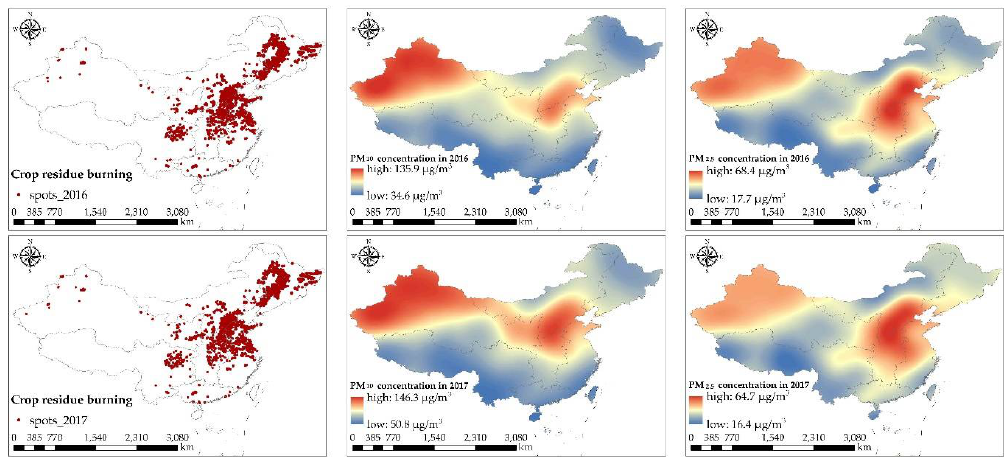
Figure 4. The spatial distribution of crop residue burning and particulate matter (PM) concentrations in the different regions of China. The left column shows the spatial distribution of crop residue burning spots in mainland China. The middle and right columns show the spatial distribution of PM 10 concentration and PM 2.5 concentration, respectively, in China by interpolating.